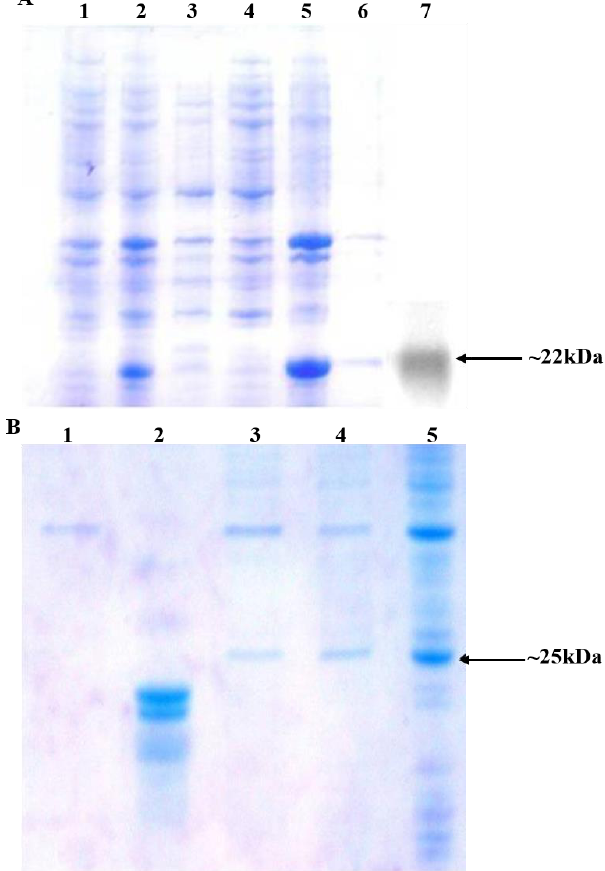
Figure 2. ( A ) Analysis of sub-cellular protein fractionations of E. coli harboring pOGH-2 by 15% SDS-PAGE and Western blotting. Lane 1: Un-induced sample; Lane 2: Total cell protein fraction from induced cells; Lane 3: Cytoplasmic fraction; Lane 4: Periplasmic fraction; Lane 5: Membrane fraction; Lane 6: Soluble fraction; Lane 7: Western blot of the purified rOGH-2 (Arrow indicates the position of rOGH at ≈ 22 kDa). ( B ) Analysis of sub-cellular protein fractionations of E. coli harboring pOGH-5 by 15% SDS-PAGE. Lane 1: Membrane fraction; Lane 2: Standard rOGH showing band at ≈ 22 kDa; Lane 3: Periplasmic fraction; Lane 4: Cytoplasmic fraction; Lane 5: Total cell protein fraction from induced cells; Arrow indicates the position of rOGH at ≈ 25 kDa.